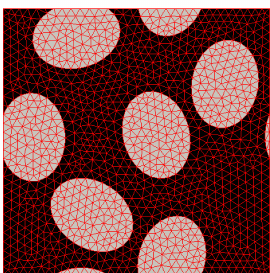
Figure 10. Real adaptive mesh of